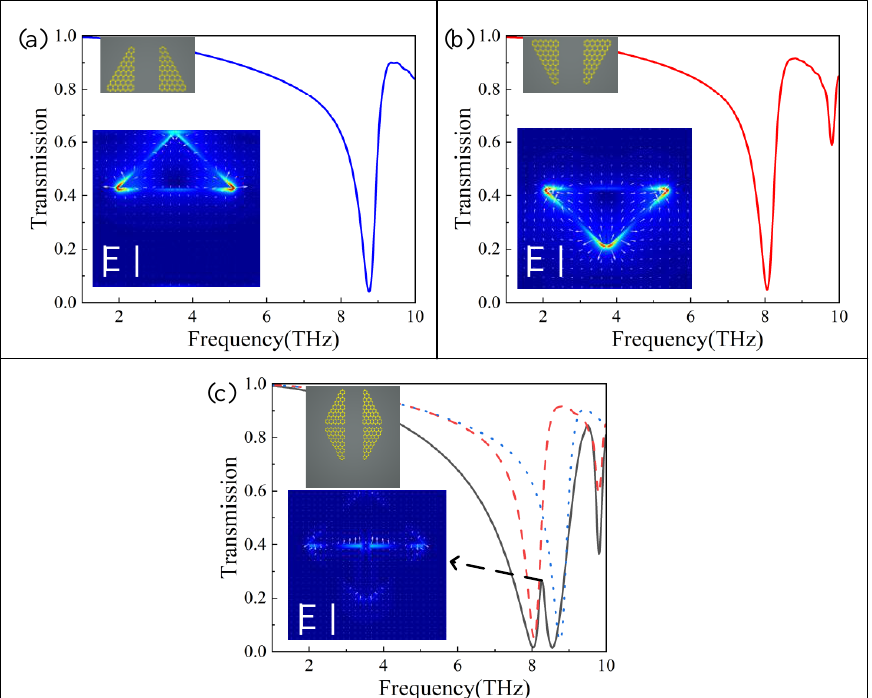
Figure 2. Transmission spectra of graphene blocks. The blue solid and dotted lines are the transmis- sion spectrum of the upper graphene block, and the red solid and dotted lines are the transmission spectrum of the lower graphene block. ( a ) The two graphene blocks in the upper part. ( b ) The two graphene blocks in the lower part. ( c ) Four graphene blocks.